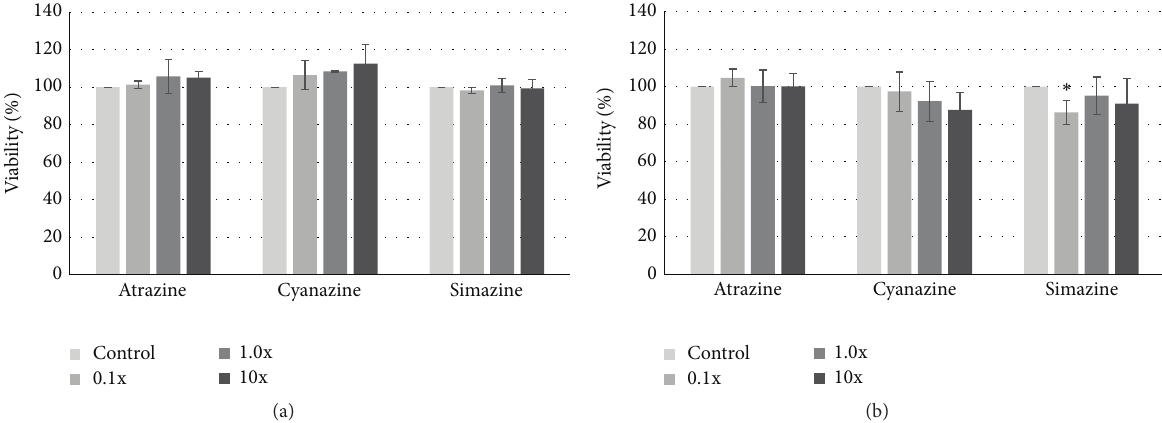
Figure 1: Cell viability of MCF-7 cells treated with triazine herbicides. MCF-7 human breast cancer cells were treated with 0.1- to 10-fold concentrations of the EPA safe levels of atrazine, cyanazine, or simazine for 24 hours in reduced (a) or maintenance (b) media. Cell viability was determined by levels of reduction of resazurin to resorufin by metabolically active cells. Percent viability of cells ± standard deviation is shown, with the DMSO-treated controls normalized to 100 percent. Statistically significant changes in viability compared to the vehicle control are indicated ( ∗ 𝑝 < 0.05 ).